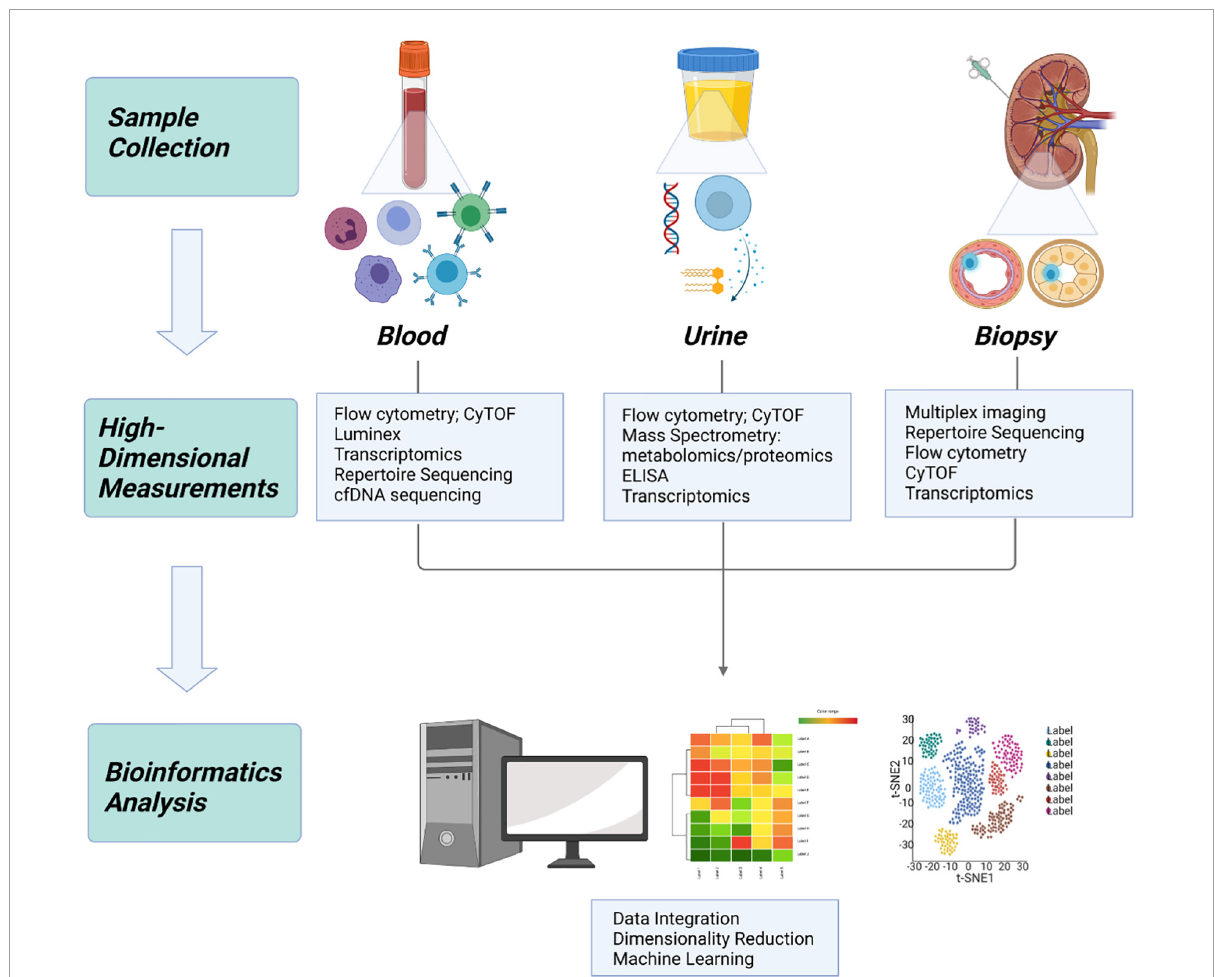
FIGURE2 Application of systems immunology to transplantation. In kidney transplantation, samples can be obtained from 3 primary sources: whole blood, urine, and allograft tissue. High dimensional measurement of each sample type provides a unique source of information, which can be integrated using bioinformatics to build a more complete understanding of the biologic